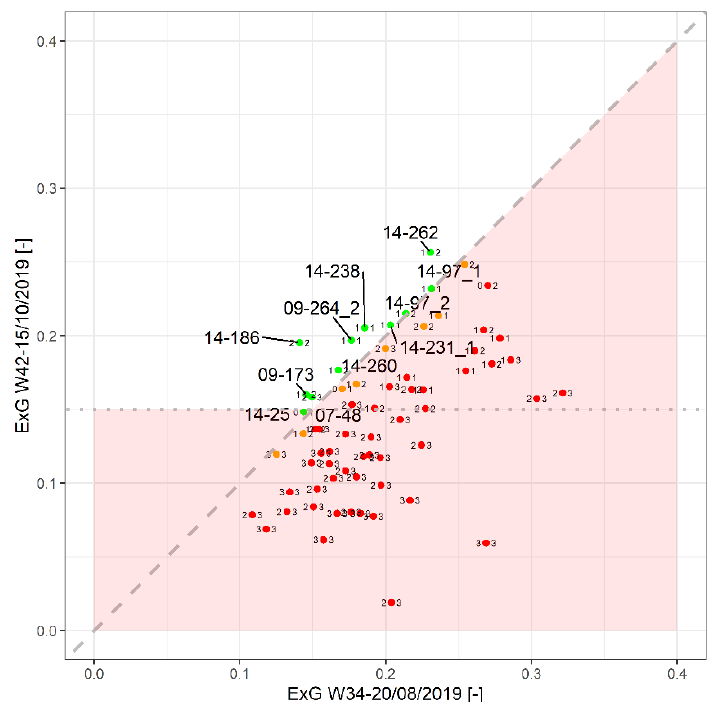
Figure 6. Evaluation of black spot disease in rose genotypes. All dots on and above the 1:1 line represent genotypes where the ExG value in the middle of October is equal to or higher than at the end of August (=reference) (green). Genotypes with an ExG reduction of ≤ 10% are shown in orange, or >10% reduction is indicated in red. For comparison, the scores of leaf spot and leaf drop per genotype (5 October 2019) are shown at the right or left of the symbol, respectively. The transparent red area indicates genotypes that can be omitted as they did not perform well for this trait (1:1 line and, e.g., a minimum ExG threshold for 5 October 2019 set by the breeder).